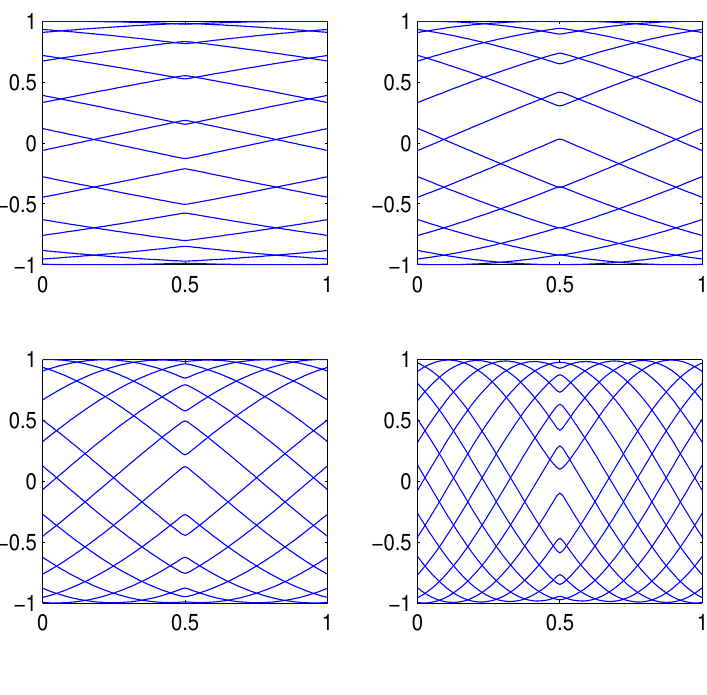
Figure 3. Behavior with respect to time of the function E in (3.8) at different values of t and four choices of the parameter ω , namely: 0.5, 1, 2,